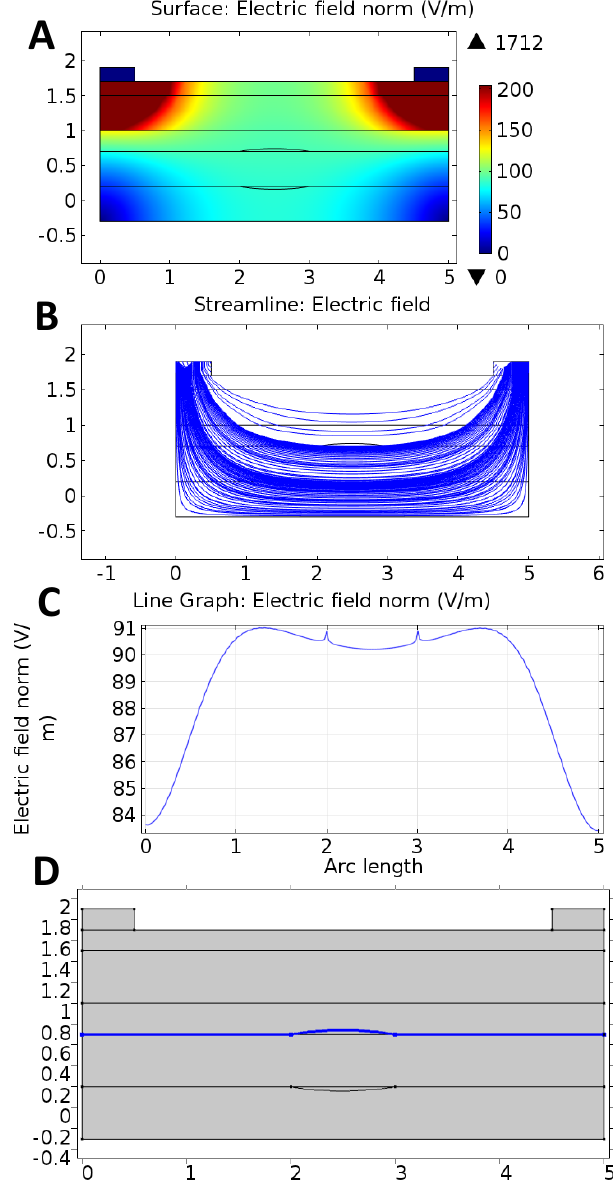
Fig. 4: The properties of the applied electric field: A) the distribution of electric field over all layers, B) the stream of electric field through all layers, C) the distribution of electric field along the artery, and D) the arc length of